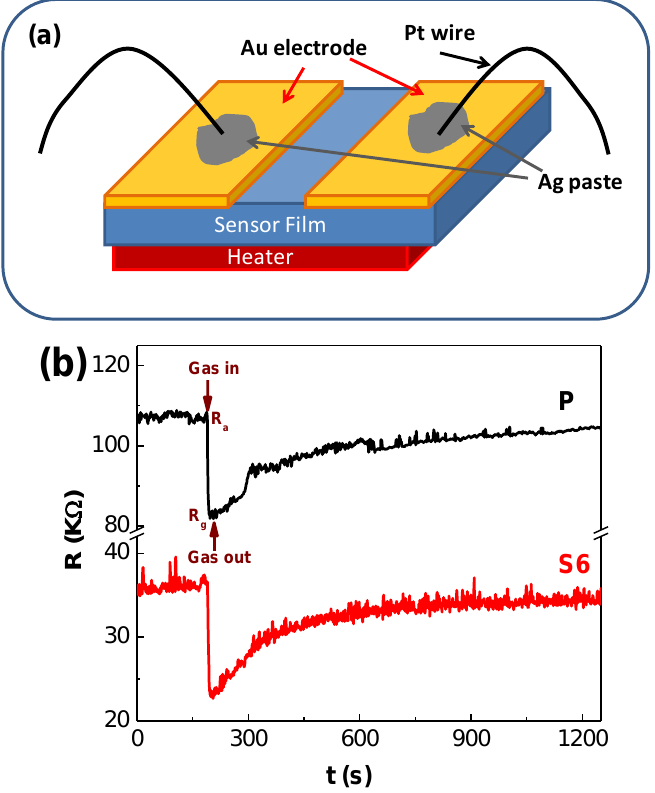
Figure 10. ( a ) Schematic of fabricated gas sensor device and the ( b ) response curves recorded for pure and Zn-doped CuO films towards 10 ppm of NO 2 at an operating temperature of 150 °C.